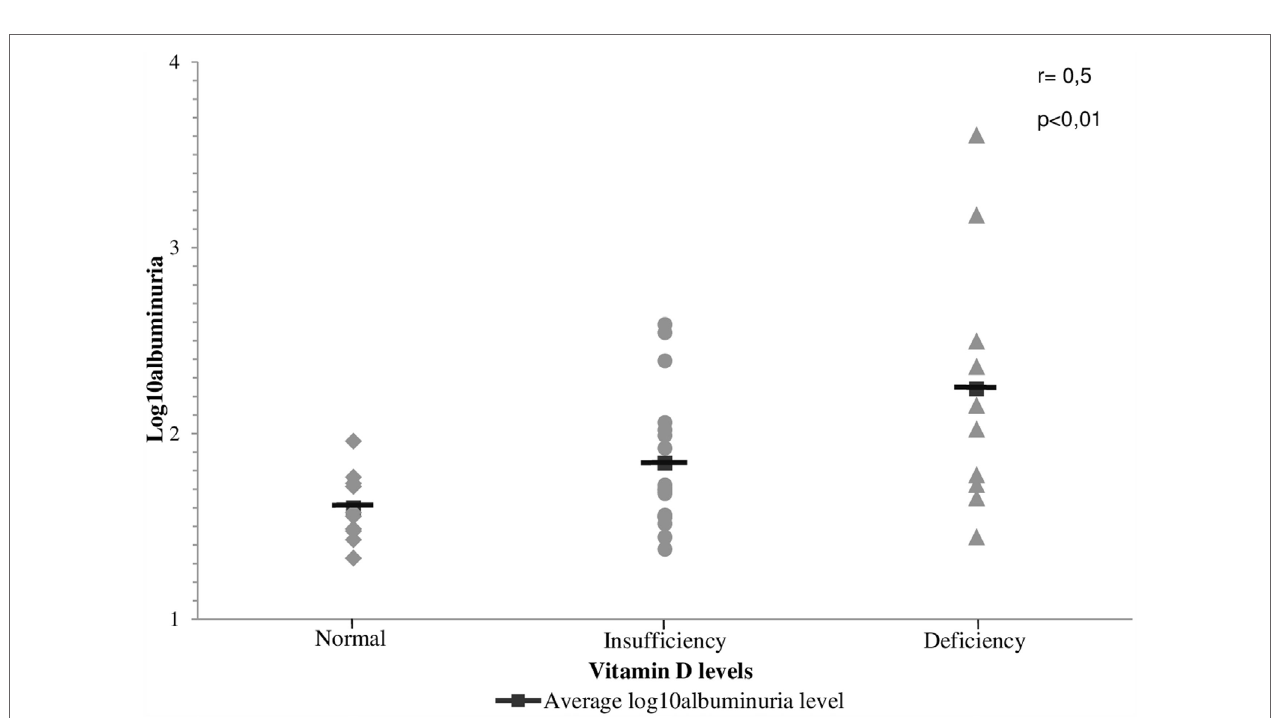
FigUre 4 | correlation between the levels of albuminuria and the status of vitamin D levels in patients with T1DM